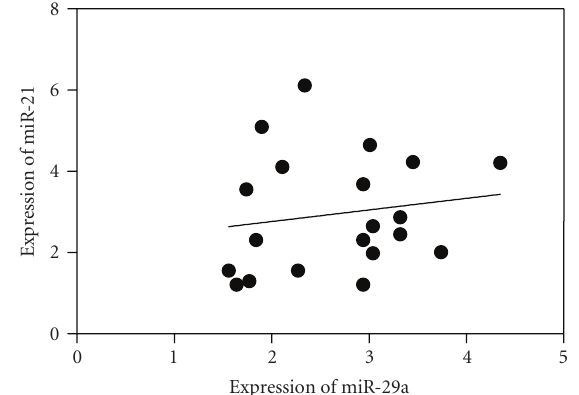
Figure 3: Scatter plot of expression level correlation between miR- 29a and miR-21 in controls (C, n = 20) and breast cancer patients (BC, n = 20). Correlation was obtained by Spearman correlation, R 2 = 0 . 298, P = . 202.